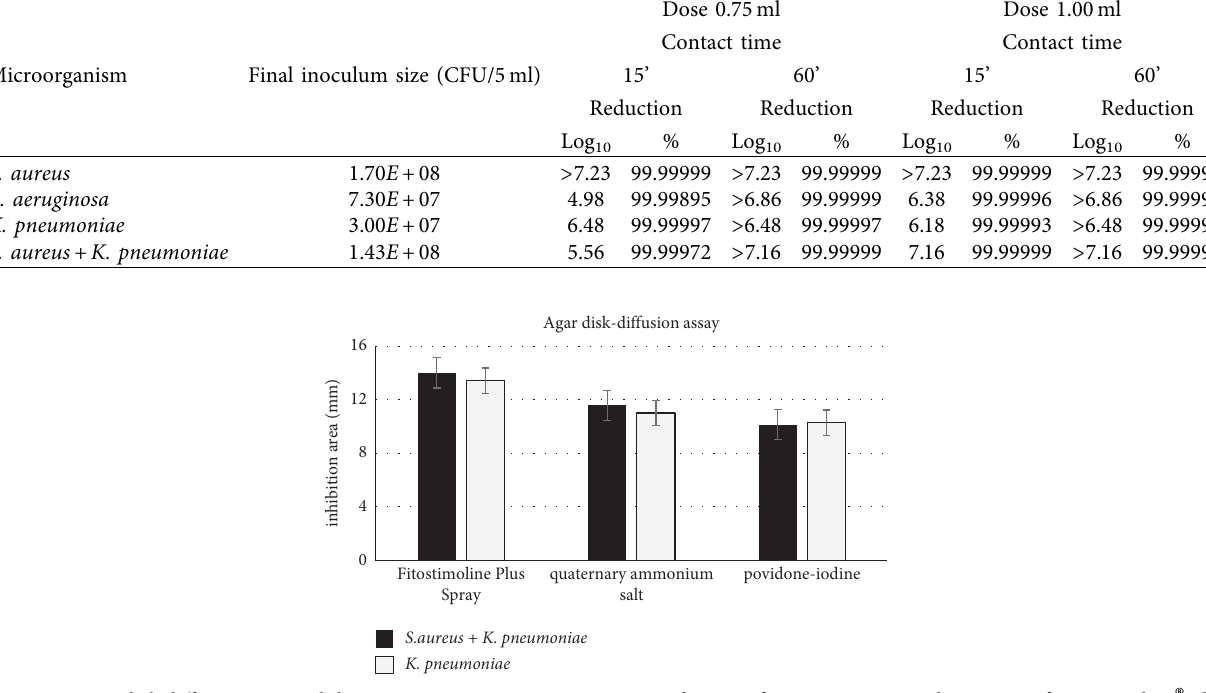
Figure 1: Agar disk diffusion assay inhibition areas against K. pneumoniae and a mix of K. pneumoniae and S. aureus of Fitostimoline ® Plus spray compared with the ones of a quaternary ammonium salt solution and povidone-iodine solution. Results are the mean ± standard deviation of three independent experiments. P values are calculated by the one-way ANOVA test ( P < 0 . 01 Fitostimoline ® Plus spray vs. each of the others).